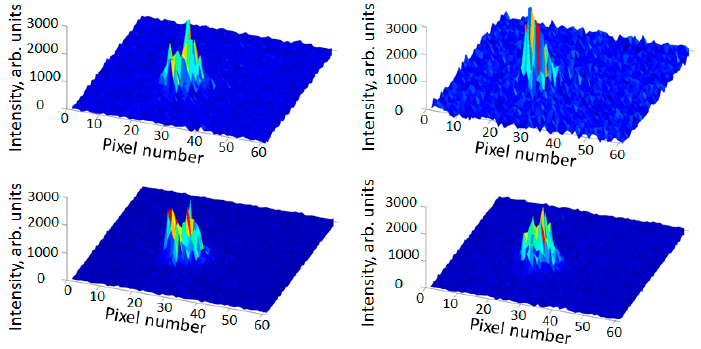
Figure 5. Four single-shot diffraction patterns measured at the same Bragg peak position. The spike-shaped peaks demonstrate an influence of the individual structure of each XFEL pulse on the Bragg peak.